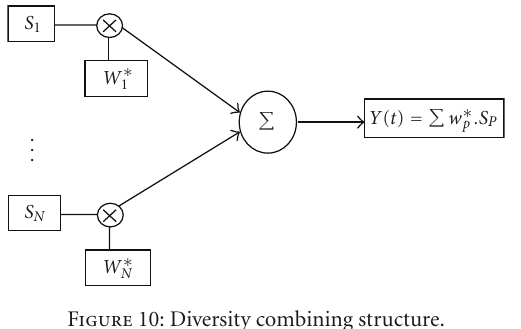
Figure 10: Diversity combining